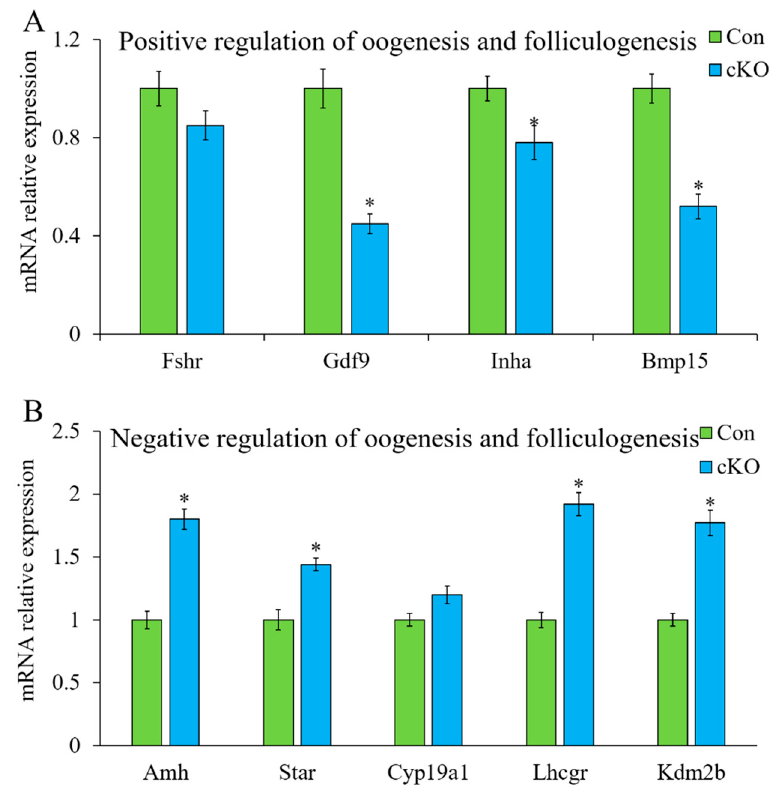
Figure 9. The mRNA expression levels of positive and negative genes related to regulate oogenesis and folliculogenesis in GV-stage oocytes. Four-week-old ovaries from Kdm2a cKO (cKO) and control (Con) mice were used to collect GV-stage oocytes; then, RT-qPCR was used to determine the levels of transcripts positively ( A ) and negatively ( B ) associated with oocyte and follicle development. n = 5 females/group. * Significant difference ( p < 0.05).